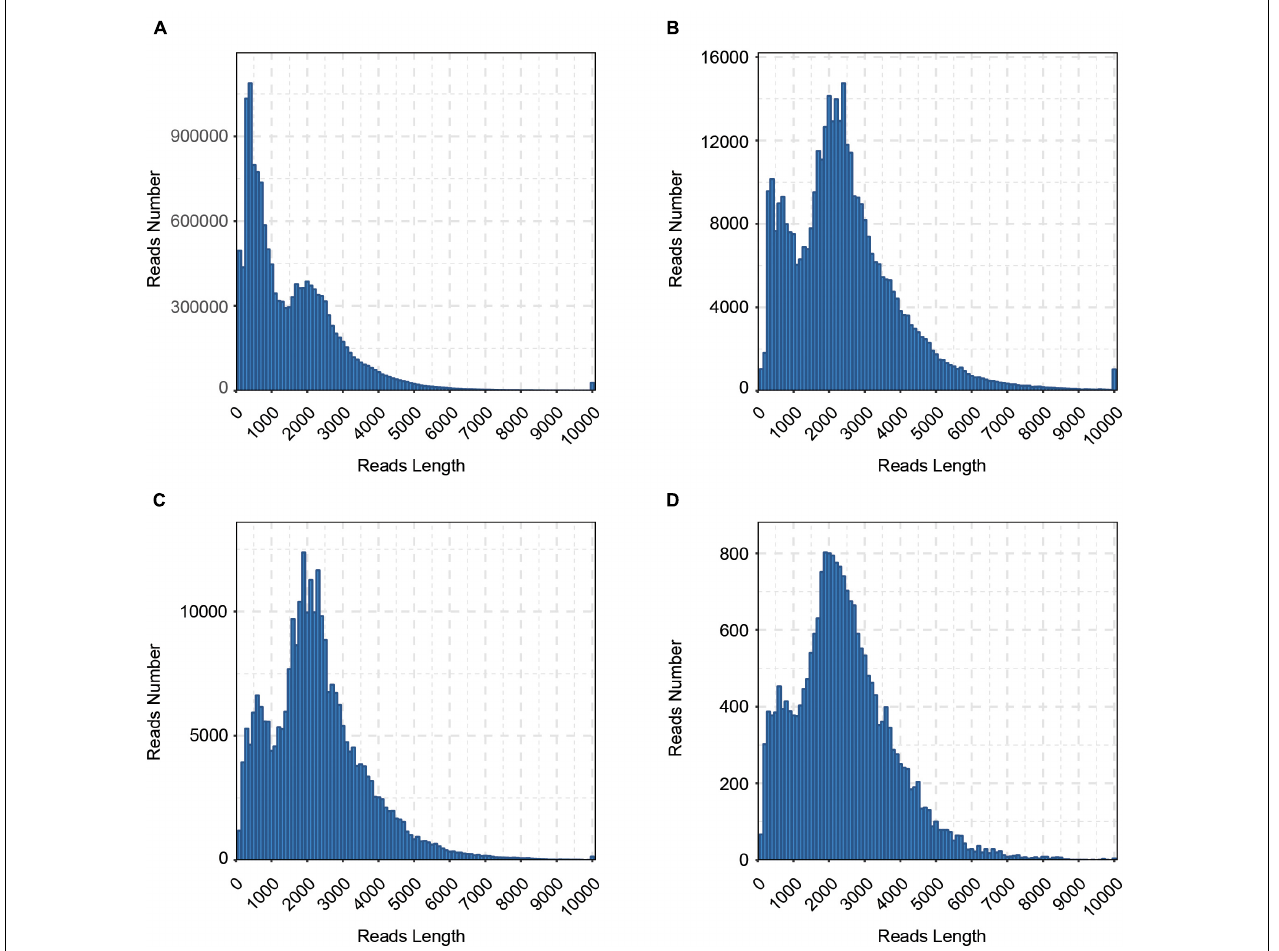
FIGURE 1 | Length distributions of PacBio SMRT sequencing. (A) Number and length distributions of 14,750,730 Subreads sequences. (B) Number and length distributions of 381,423 CCS sequences. (C) Number and length distributions of 276,295 FLNC sequences. (D) Number and length distributions of 22,353 corrected sequences.